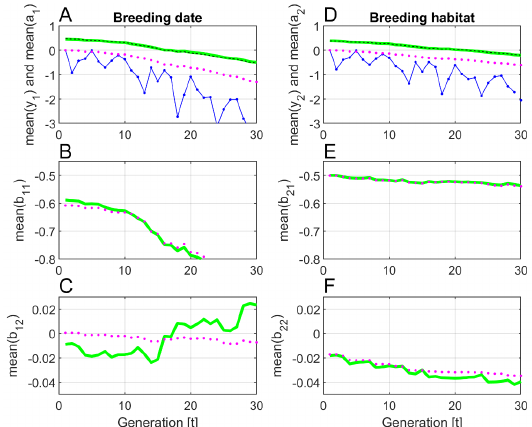
Figure 5: Typical responses for Case 2 in Table 1, al- though especially the plots in Panel C varies a lot from realization to realization. True y 1 ,t and y values are shown by solid blue lines, 2 ,t while final predictions (cid:98) y and (cid:98) y are shown 1 ,t 2 ,t by blue dots. True mean trait responses are shown by green lines, while predictions are shown by magenta dots. Corrected predic- tions as discussed in Subsection 2.2 are shown by black dashed